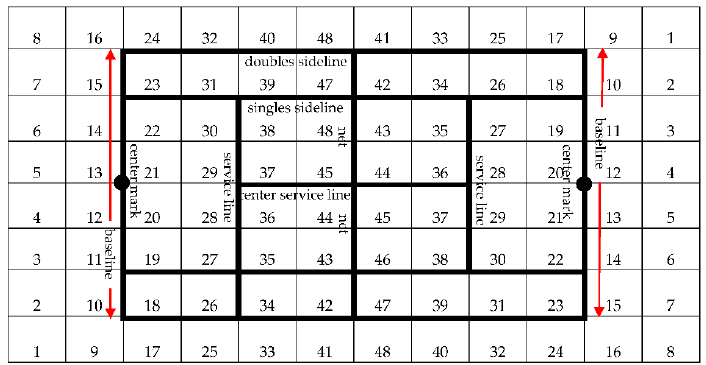
Figure 2. Player’s position codes.